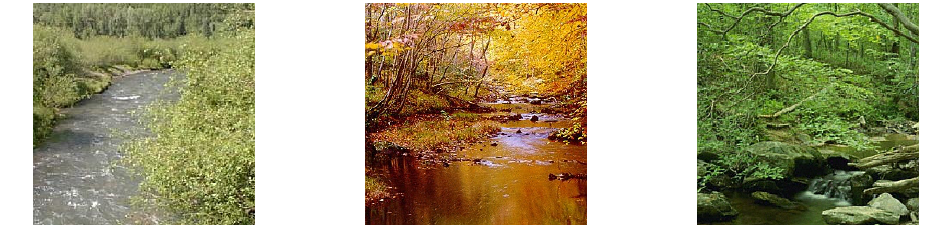
Figure 1. Image may be associated with more than one semantic category. Three images listed here can be annotated with the scene of rivers or